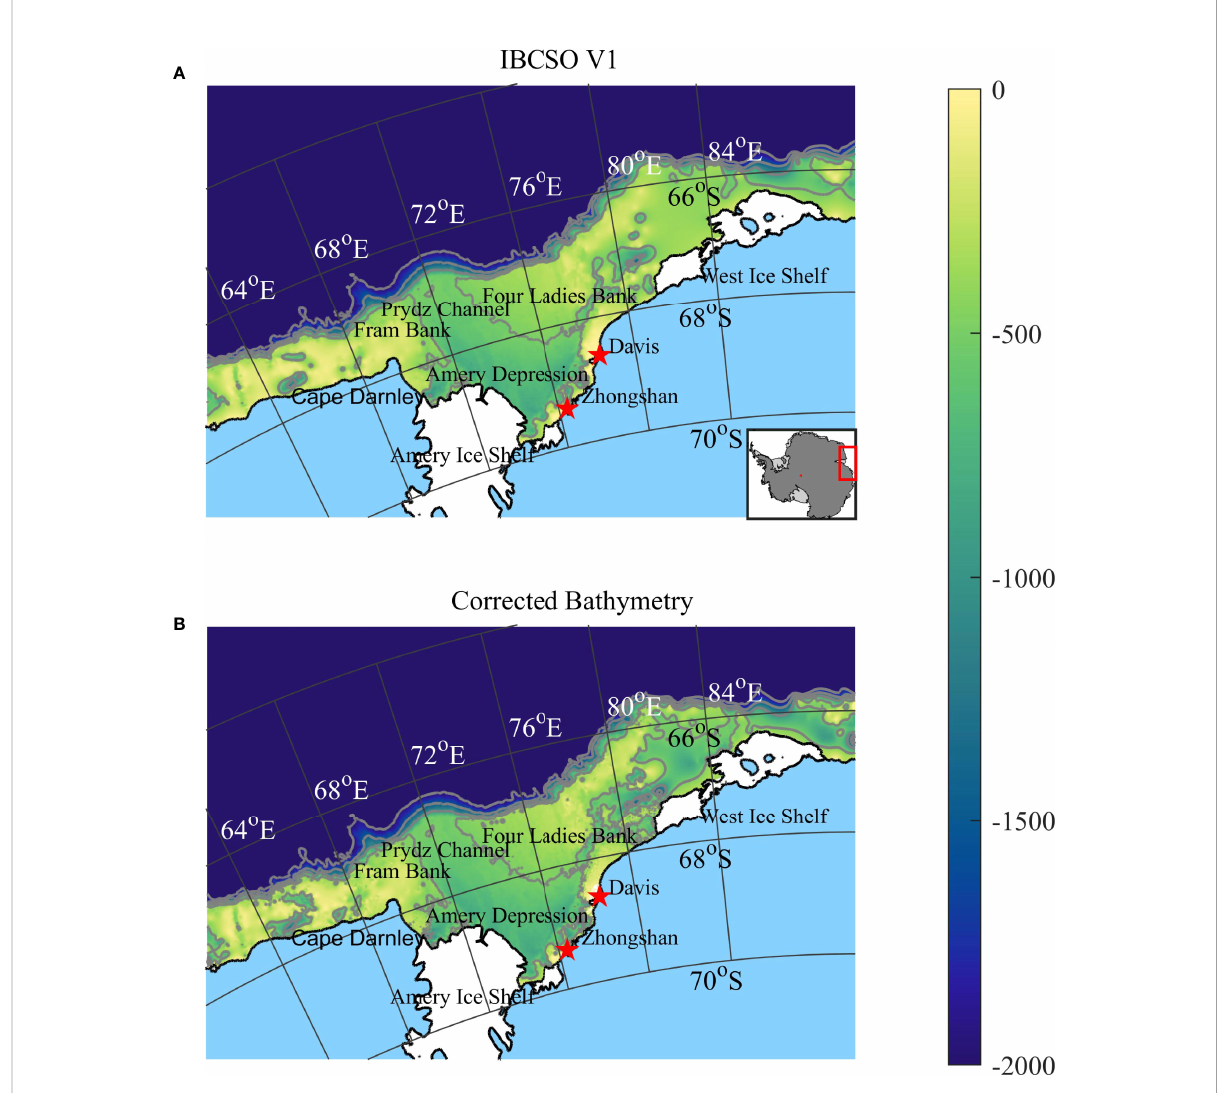
FIGURE 1 (A) Bathymetry (m) for Prydz Bay from IBCSO Version 1.0. Ice shelves, main topographical features, and the research stations (red stars) are marked at the corresponding locations. Ice shelves are shaded in white, and the land is shaded in light blue. The grey lines are bathymetric contours from IBCSO V1 from 500 to 2000 m with an interval of 500 m. (B) Same as (A) , but for the CB